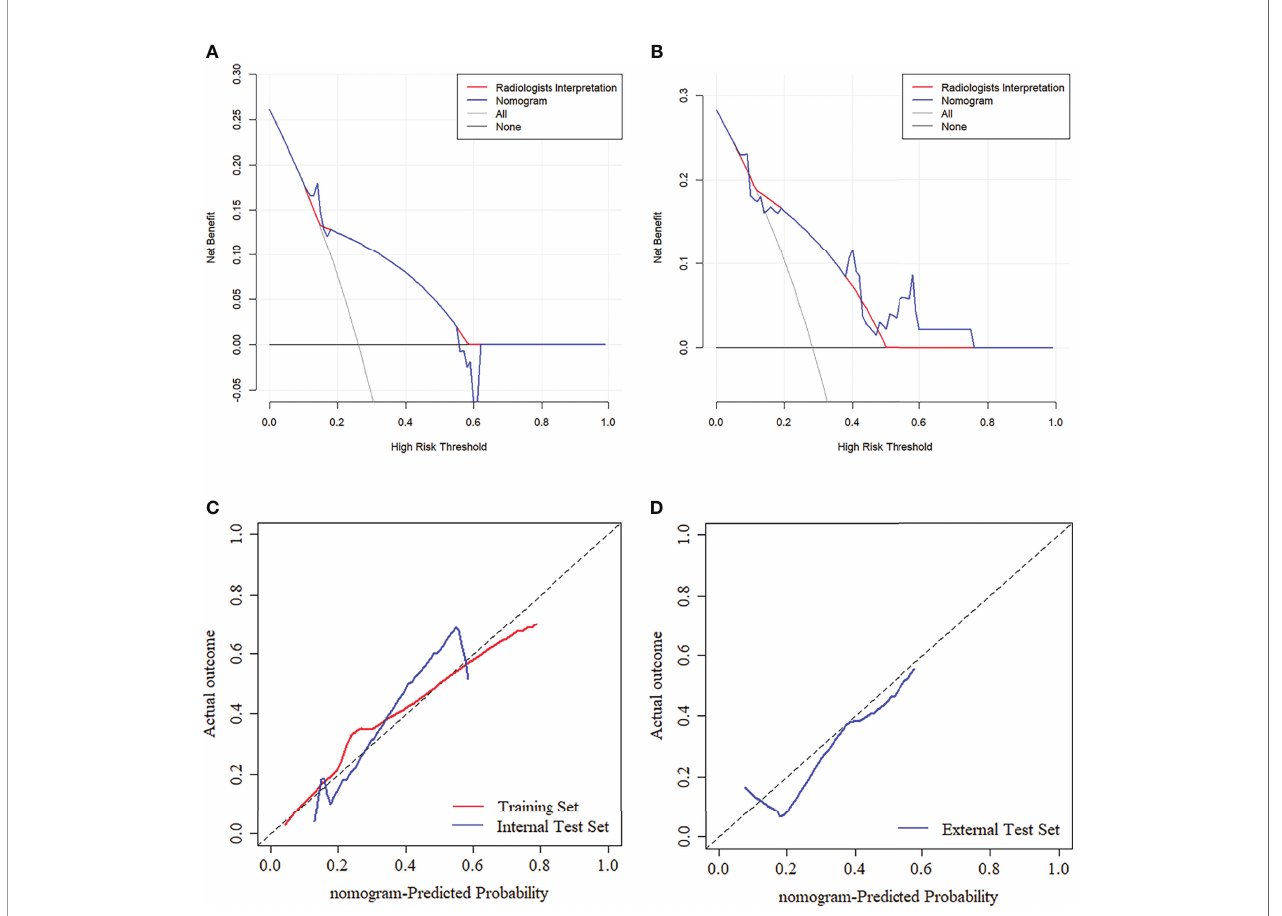
FIGURE 5 | (A, B) Decision curve analysis (DCA) for the prediction models in the internal and external test set. The y-axis represents the net bene fi ts, while the x- axis represents the threshold probability. The blue line represents the radiomics nomogram. The red line represents the radiologists ’ interpretation model. The gray line represents the assumption that no patients were diagnosed as ETE. The horizontal black line represents the assumption that all patients were diagnosed as ETE. Calibration curves of radiomics nomogram in the training (C) , internal test (C) , and external test (D) sets. The diagonal line represents the perfect prediction of the radiomics